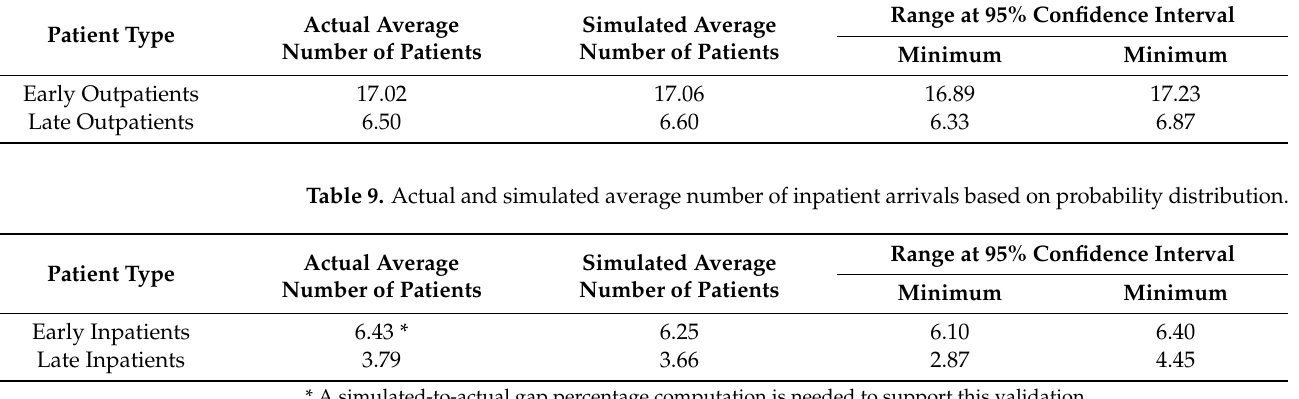
Table 8. Actual and simulated average number of outpatient arrivals based on probability distribution.